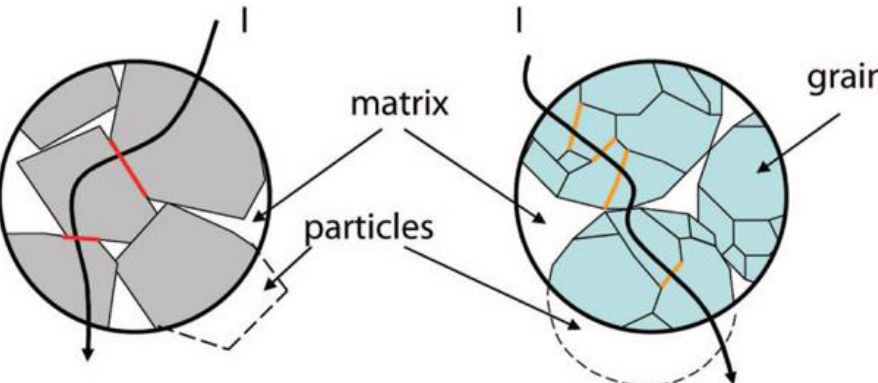
Figure 5. Schematic of the microstructures of field-grading materials based on SiC ( left ) and ZnO microvaristors ( right ). Arrow: possible current path; red: particle – particle contact responsible for the nonlinearity in SiC-based materials; orange: grain boundary responsible for the nonlinearity in microvaristor-based materials. © 2021 IEEE. Reprinted, with permission, from Ref. [42].